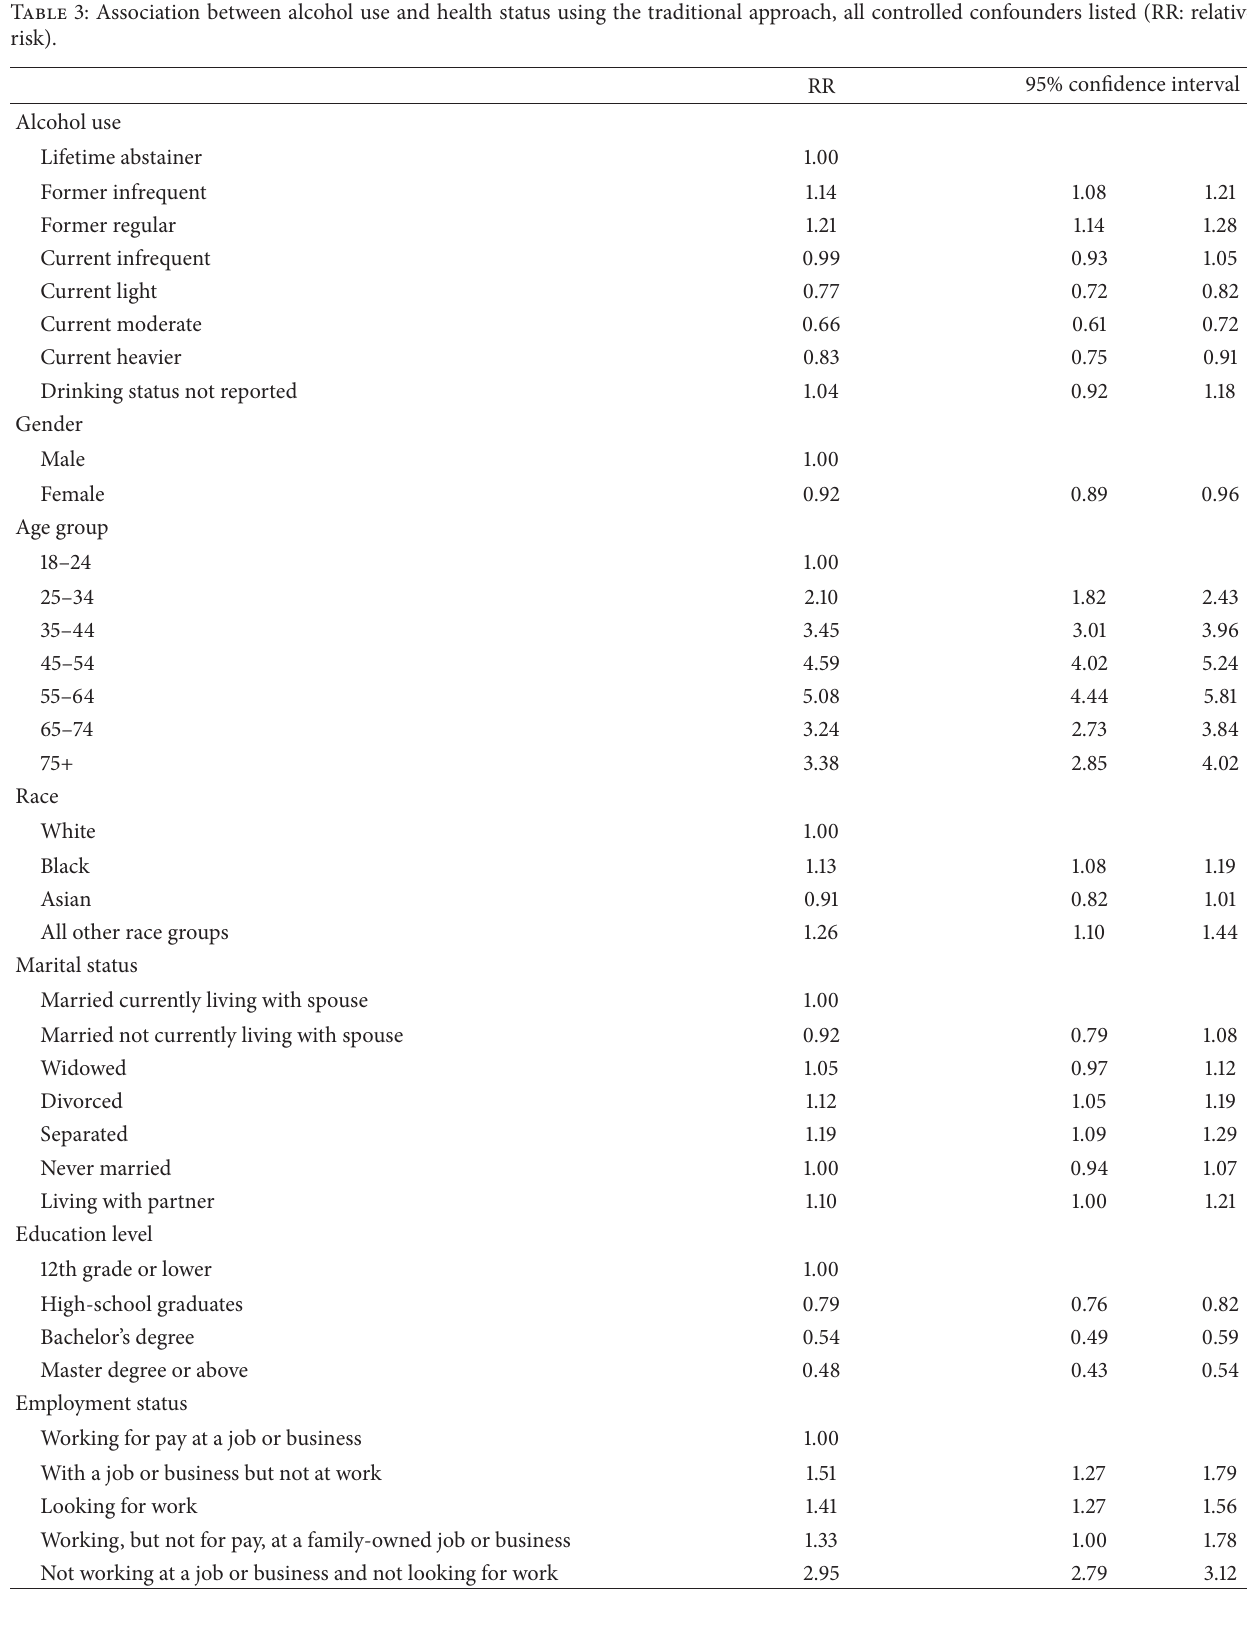
Table 3: Association between alcohol use and health status using the traditional approach, all controlled confounders listed (RR: relative